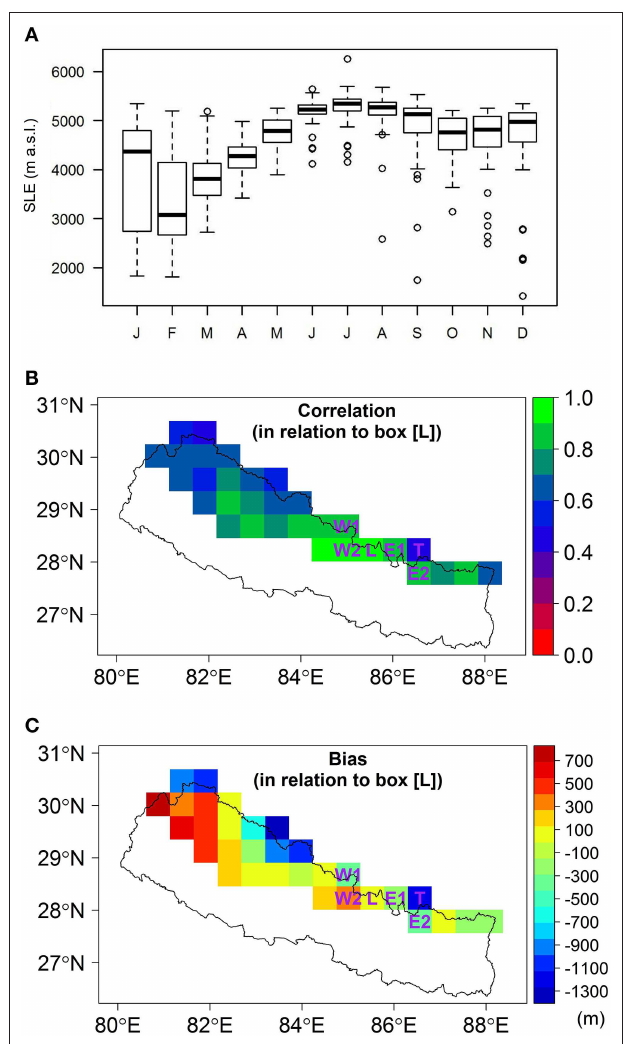
FIGURE 4 | (A) Box-and-whiskers plot of the monthly distribution of observation-based SLE in 2001–2017 in a 50 × 50km box over the Langtang catchment. The boxes and black line denote the 25 and 75% percentiles and the median, respectively. The whiskers denote the lowest and highest data point still within 1.5 times the interquartile range below and above the box. Data points outside the whiskers are denoted by circles. (B) Correlation and (C) bias of observation-based SLE time series between the 50 × 50km box over the Langtang catchment (denoted by “L”) and 30 other similar rectangular boxes over the Nepal Himalayan region. Positive bias values mean a lower SLE than in the Langtang box. The letters indicate neighboring boxes toward the Tibetan Plateau (T), toward west (W1, W2) and toward east (E1, E2) of the Langtang box (L). All the SLE values are derived from MODIS satellite images (8-day maximum